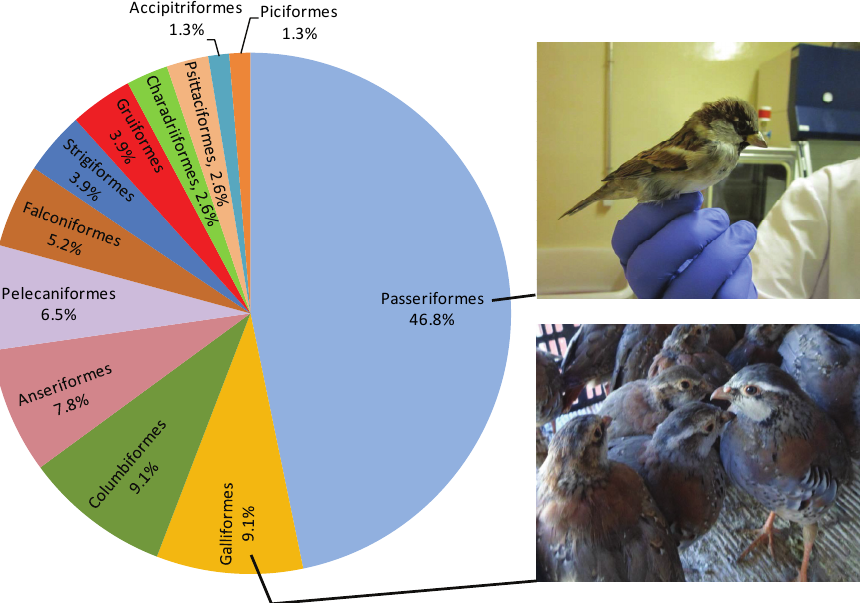
Figure 1. Percentage of wild bird species, distributed by order, used in WNV experimental infections. Pictures show two representative species used in this type of experiments by the authors’ group: House sparrow ( Passer domesticus ) and Red-legged partridge ( Alectoris rufa ).